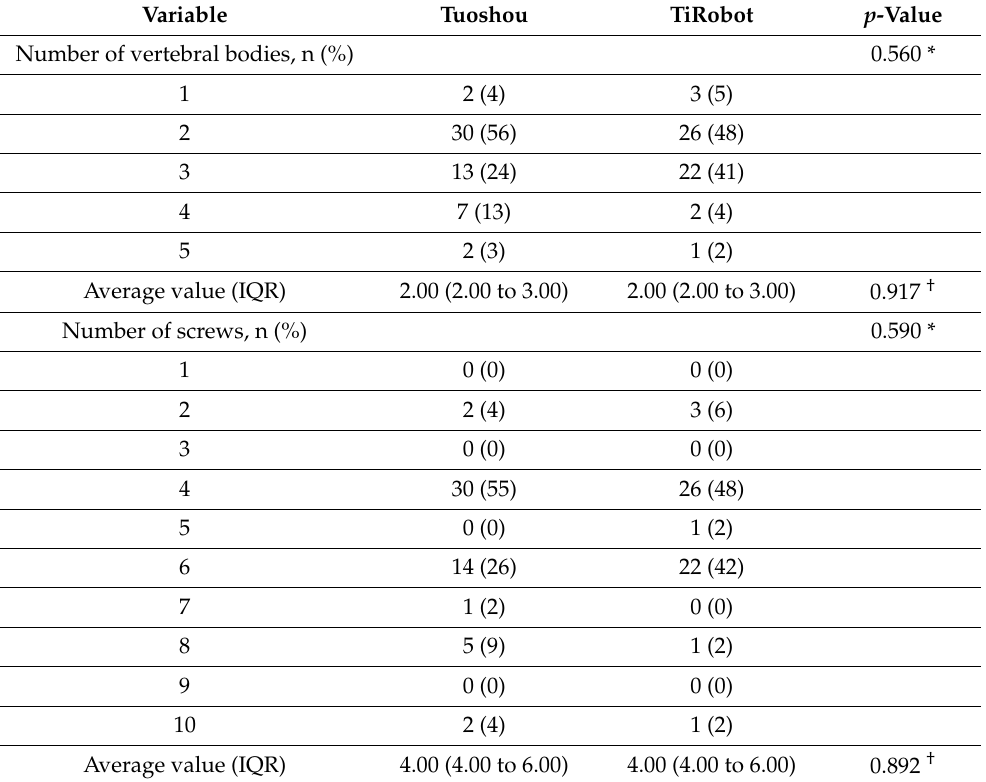
Table 3. Number of vertebral bodies and screws. Variable Tuoshou TiRobot Number of vertebral bodies, n (%)